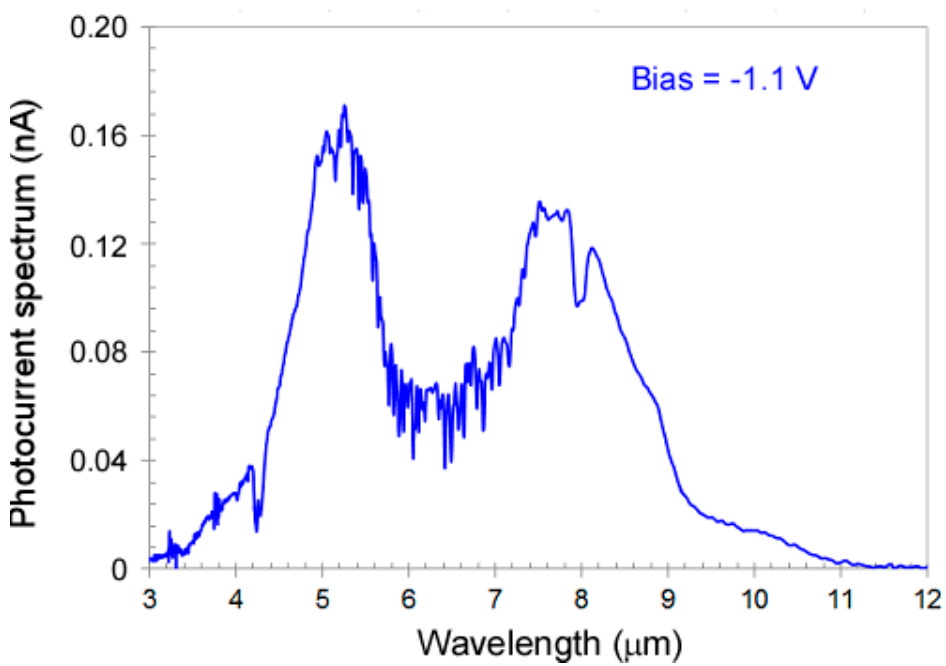
Figure 4. Photocurrent spectrum of the dual-band QDIP under bias voltages of − 1.1 V. At this bias, the QDIP covers both the MWIR and the LWIR bands.